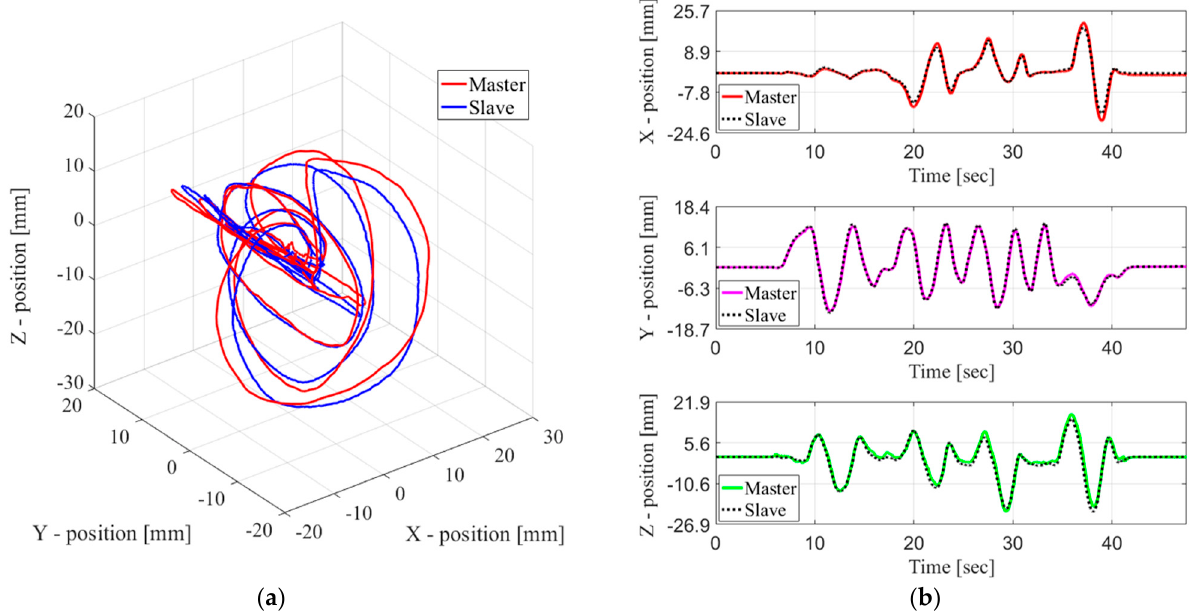
Figure 10. Result of the master–slave control in the developed teleoperation system: ( a ) in 3D space; ( b ) in 2D space X , Y , and Z axis. Table 4. Measured error of the EE on the